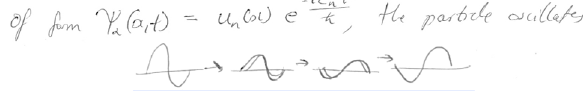
FIG. 1. An example of student work showing inconsistency between representations for the time development of an energy eigenstate in an infinite square well. The student has written the correct mathematical expression, but an incorrect visual